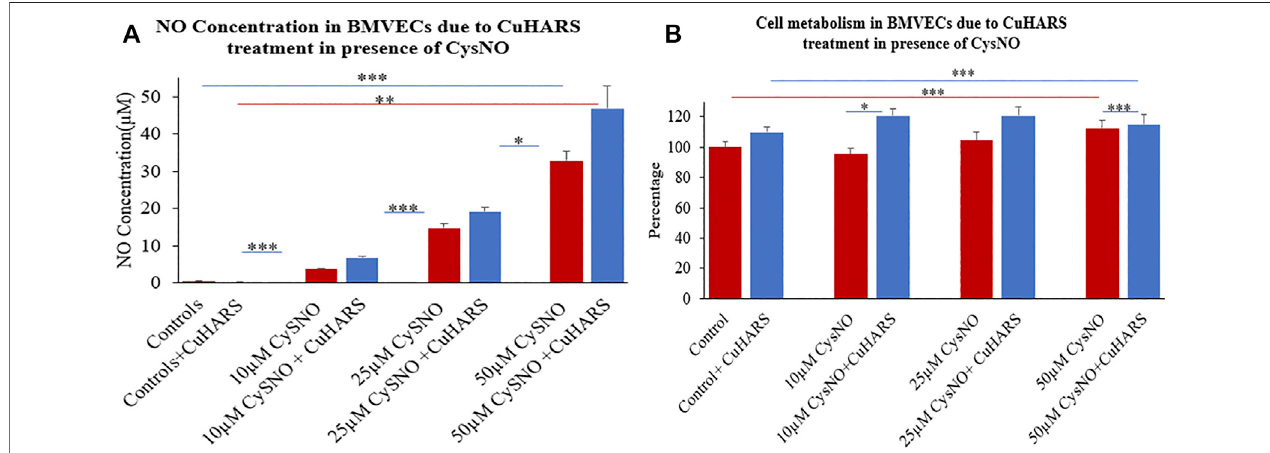
FIGURE 6 | Normal brain endothelial cell (BMVECs) response to 20 μ g/ml CuHARS treatment in presence of three different concentrations (10, 25 and 50 µM) of CysNO. (A) NOconcentrationintheBMVECsduetothetreatmentshowingsigni fi cantincrease inNOreleasefrom cellstreatedwithCuHARS compared tocellstreated with CysNO alone. (B) Cell metabolism due to the treatment showing increase in cellular metabolism for CuHARS treated cells compared to when treated with CysNO alone. Data represent average of three experiments ( N (cid:2) 3) with triplicated wells ( n (cid:2) 3). The error bars represent SEM values, “ *** ” represents p < 0.001, “ ** ” represents p < 0.01 and “ * ” represents p <